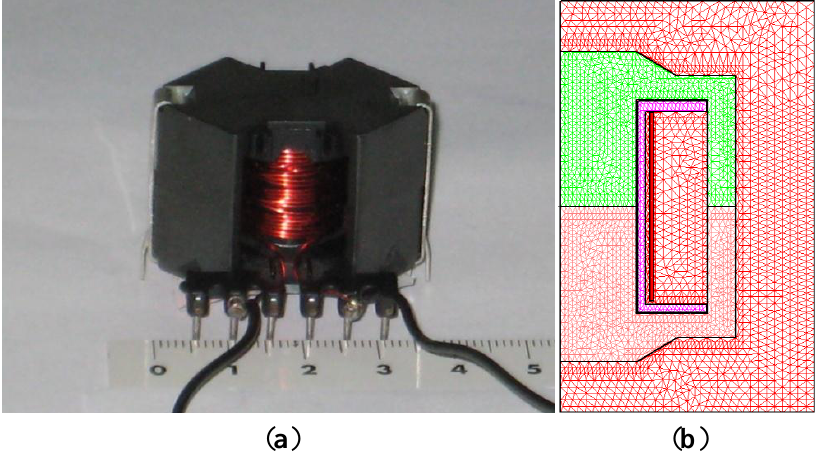
Figure 2. ( a ) Real inductor with an RM-shaped core; and ( b ) 2D model and triangular mesh generated by the 2D